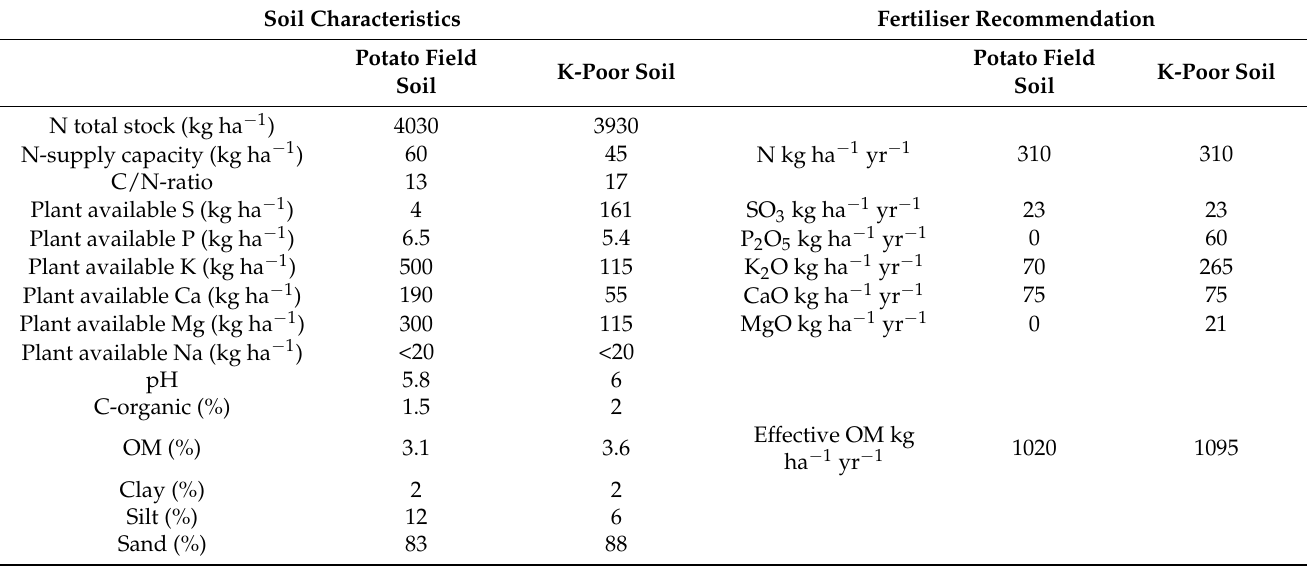
Table 2. Initial characteristics of the two soils that were used for this study and the fertiliser recom- mendations for growing consumption